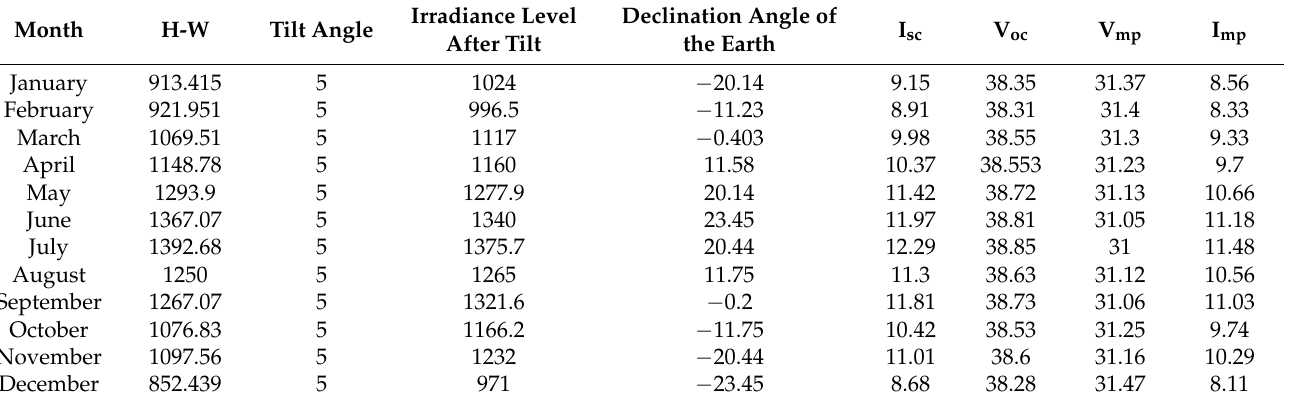
Table 2. Monthly specific daily global irradiance (H), optimal tilt angle (deg), declination angle of